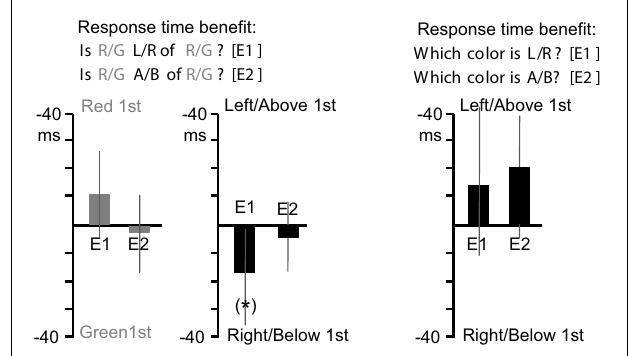
FIGUREA1 | Response time benefits for Experiments 1 and 2. The first graph (grey bars), depicts response times advantages for the “IsTarget Direction of Reference?” question type.Values toward graph top indicate faster responses for trials where the Red object appeared first, and values toward graph bottom indicate faster responses for trials where the Green object appeared first. In the second graph (black bars), values toward graph top indicate faster responses for trials where Left (E1) or Above (E2) object appeared first, and values toward graph bottom indicate faster responses for trials of the opposite cases.The third graph depicts equivalent results for the “Which Color is Direction?” question type. *Indicates a single marginal effect (which would not survive a multiple comparisons